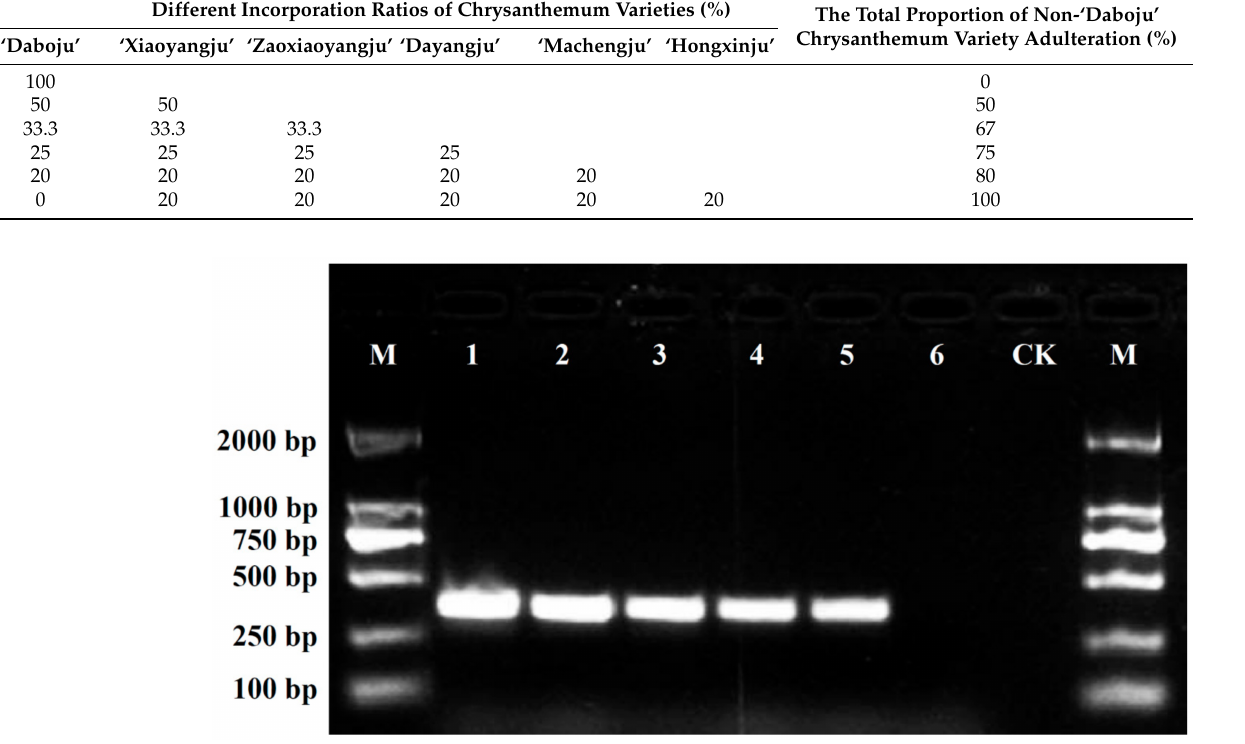
Figure 6. Amplification profiles of the primer pair DBJF/DBJR in genomic DNA composed of different combinations of C. morifolium cultivars. Lane M: Trans2K DNA markers with specified amplification product band lengths (bp); lanes 1–6: different proportions of adulteration of C. morifolium